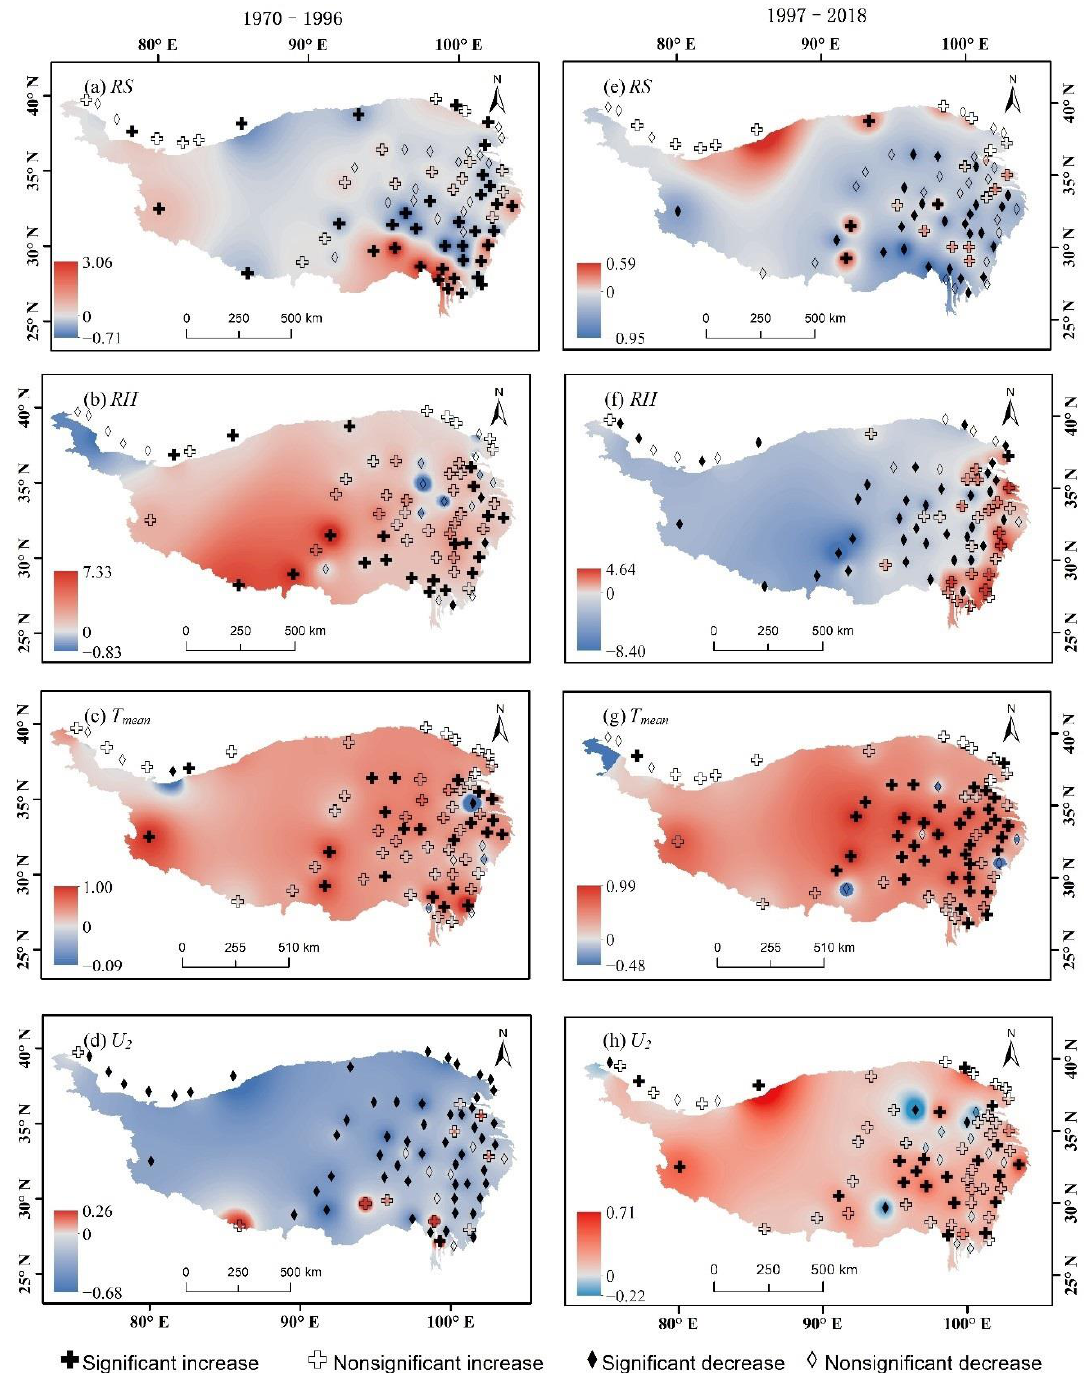
Figure 6. Spatial distribution of climatic factors trends during 1970 – 1996 ( a – d ) and 1997 – 2018 ( e – h ); ( a , e ) RS ((MJ m −2 day −1 )/decade); ( b , f ) RH (%/decade); ( c , g ) T mean (°C/decade); ( d , h ) U 2 (m/s/decade).